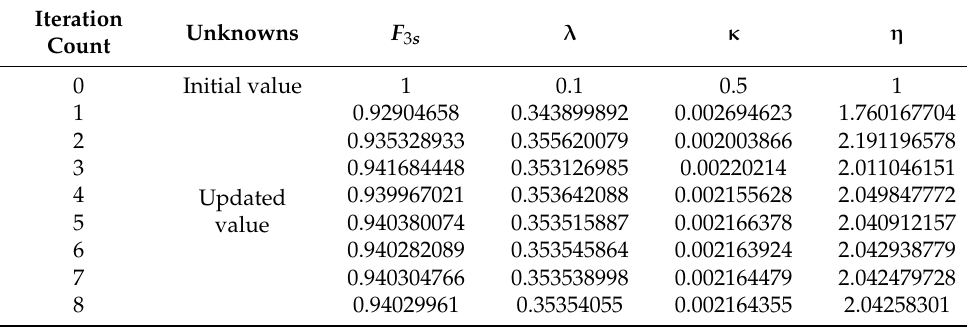
Table 1. Iteration process for solving unknowns in the